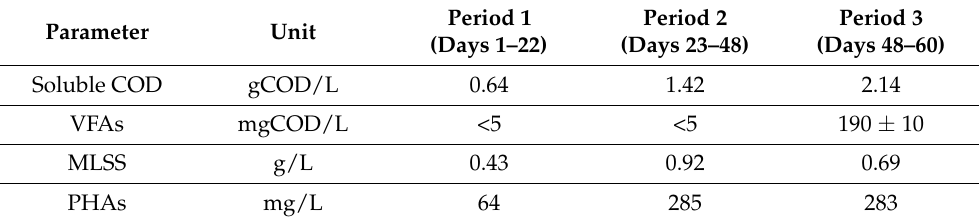
Table 2. Concentration of soluble COD, VFAs, MLSS, and PHAs in the effluent of the